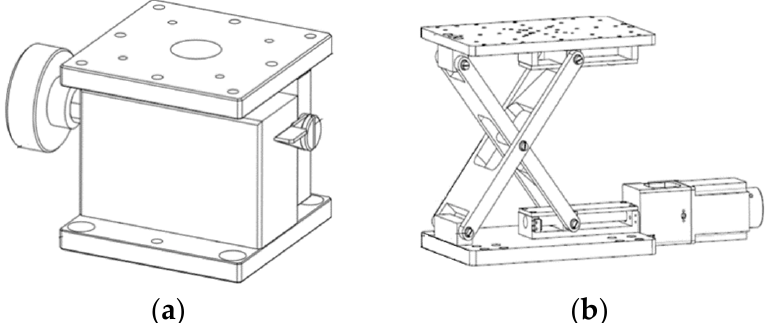
Figure 9. Height lift adjustment mechanism: ( a ) manual operation and ( b ) electric controls.